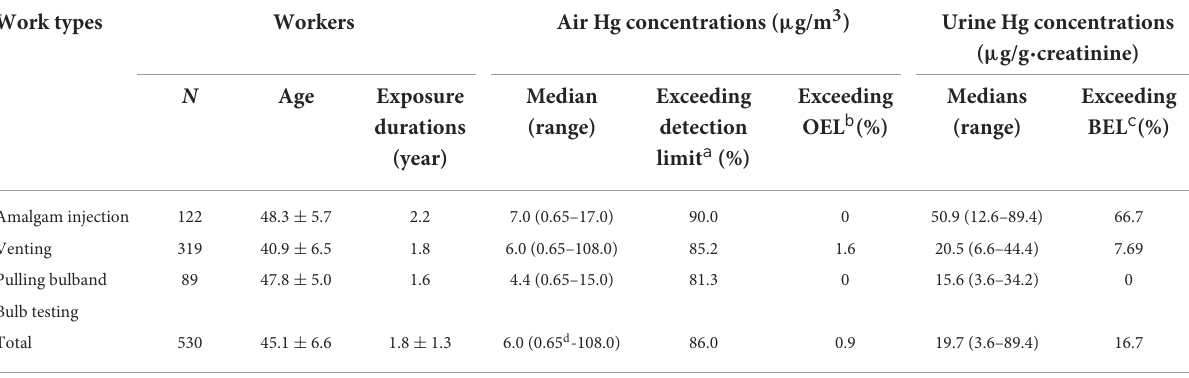
TABLE 2 General information for similar exposure groups at key mercury (Hg) exposure